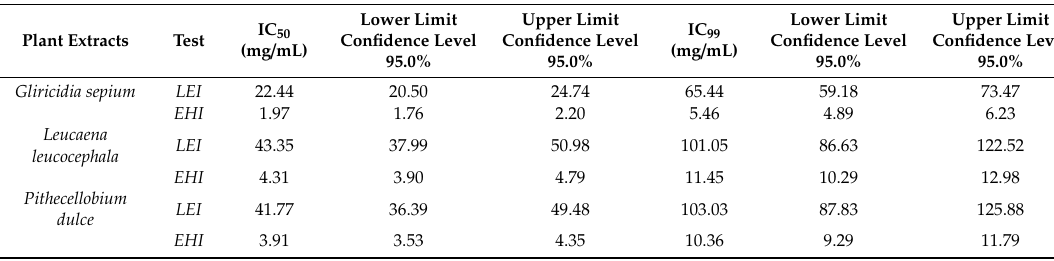
Table 3. IC 50 and IC 99 of extracts for larval exsheathment inhibition (LEI) and egg hatch inhibition (EHI).